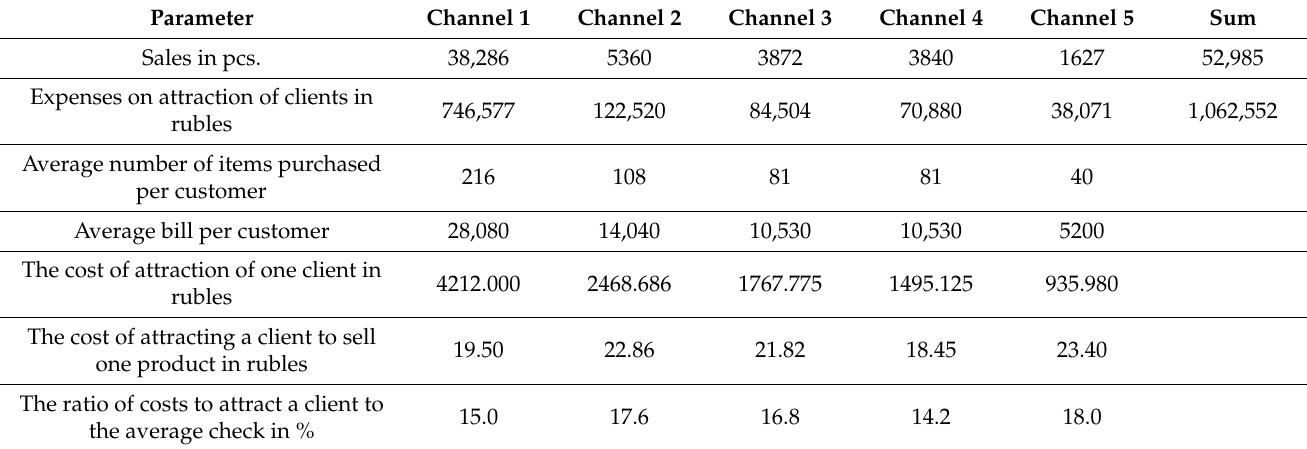
Table 11. Data on sales in different product sales channels in